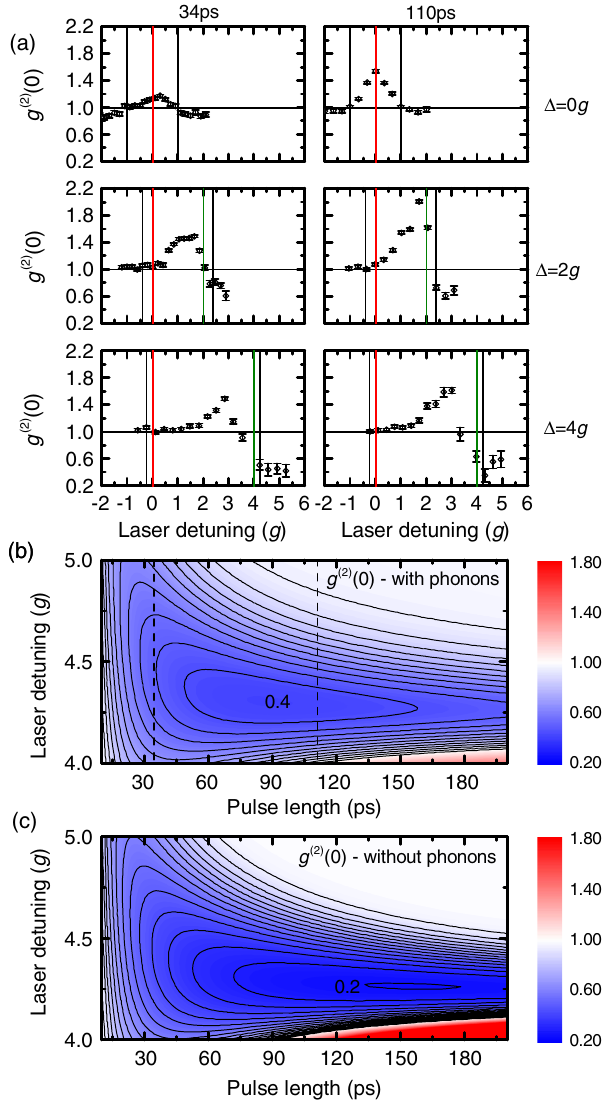
FIG. 3. (a) Measured second-order coherence g ð 2 Þ ð 0 Þ as a function of the laser detuning for different QD-cavity detunings (top to bottom) and excitation pulse lengths (left to right). In each case, the red vertical line indicates the bare cavity frequency, the green vertical line indicates the bare QD frequency, and the black vertical lines indicate the polariton frequencies. (b-c) Simulated photon-blockade values of g ð 2 Þ ð 0 Þ as a function of the laser detuning and pulse length including (b) and excluding (c) the effect of phonons, both at a QD-cavity detuning of Δ ¼ 4 g . To aid in comparison with the experimental results in (a), the dashed lines in (b) indicate the simulated antibunching values for the photon blockade at the experimental pulse lengths.